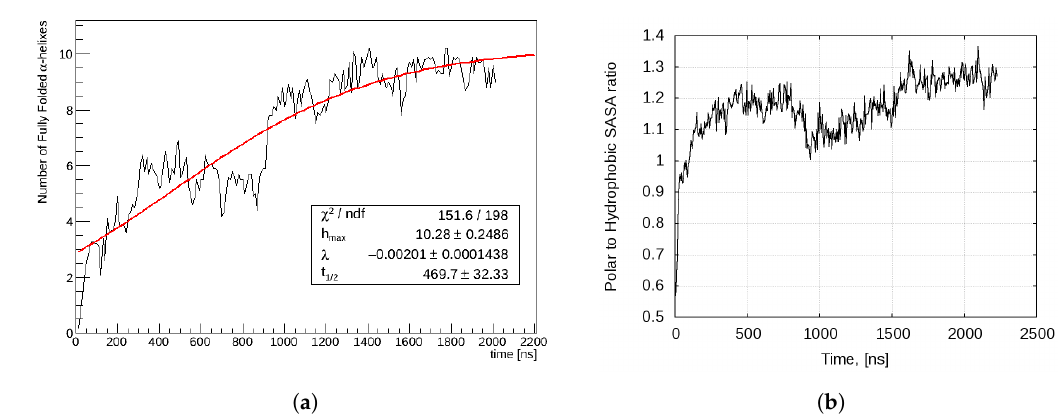
Figure 7. ( a ) Number of monomers in the single-helix state; and ( b ) polar to hydrophobic SASA